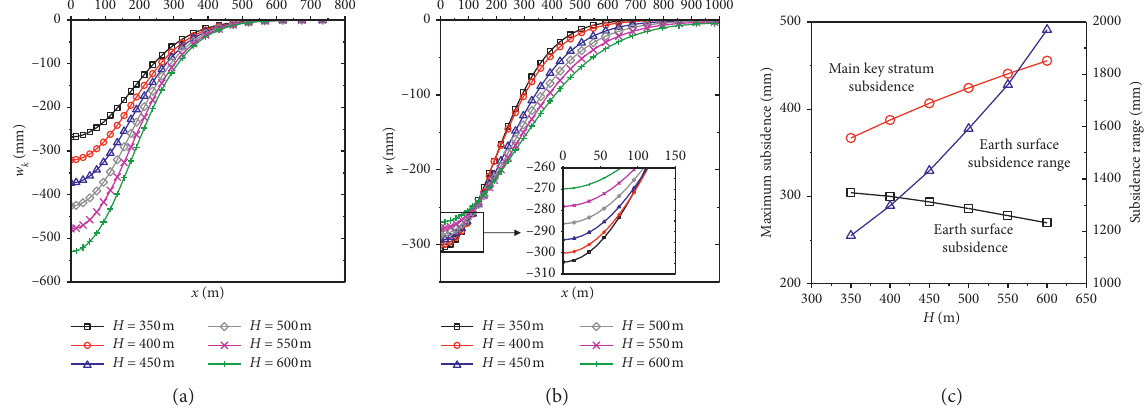
Figure 11: (a) Subsidence curve of main key strata, (b) surface subsidence curve, and (c) maximum subsidence and variation curve of surface subsidence range at different mining depths.